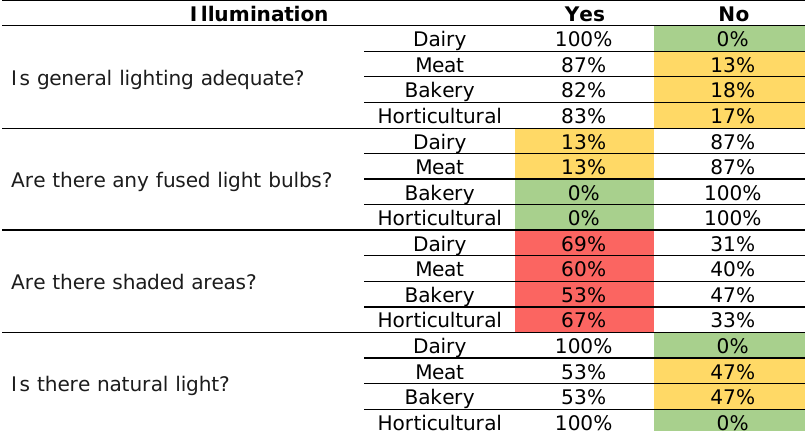
Table 7. Compliance of lighting with OSH for the audited